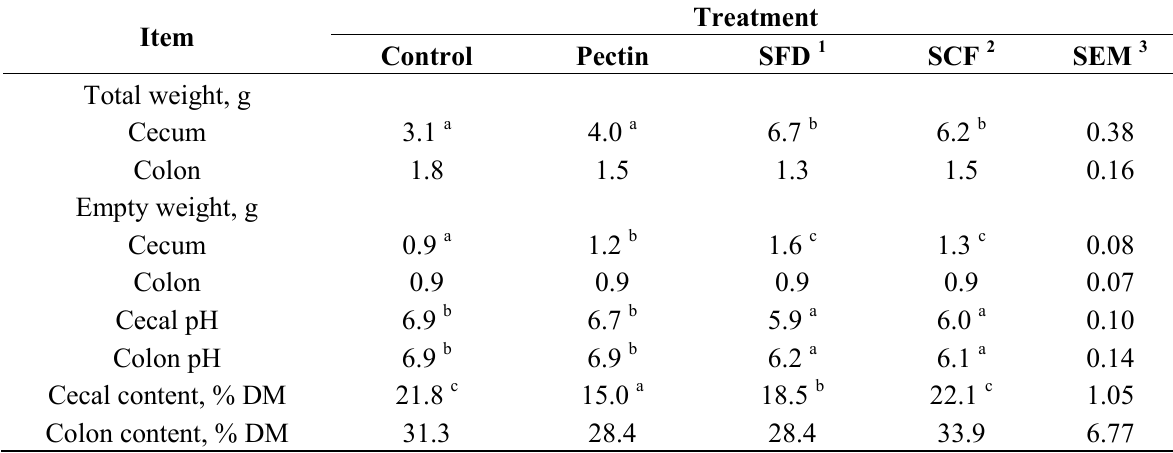
Table 3. Cecal and colonic total and empty weights, pH, and dry matter content values in rats fed select dietary